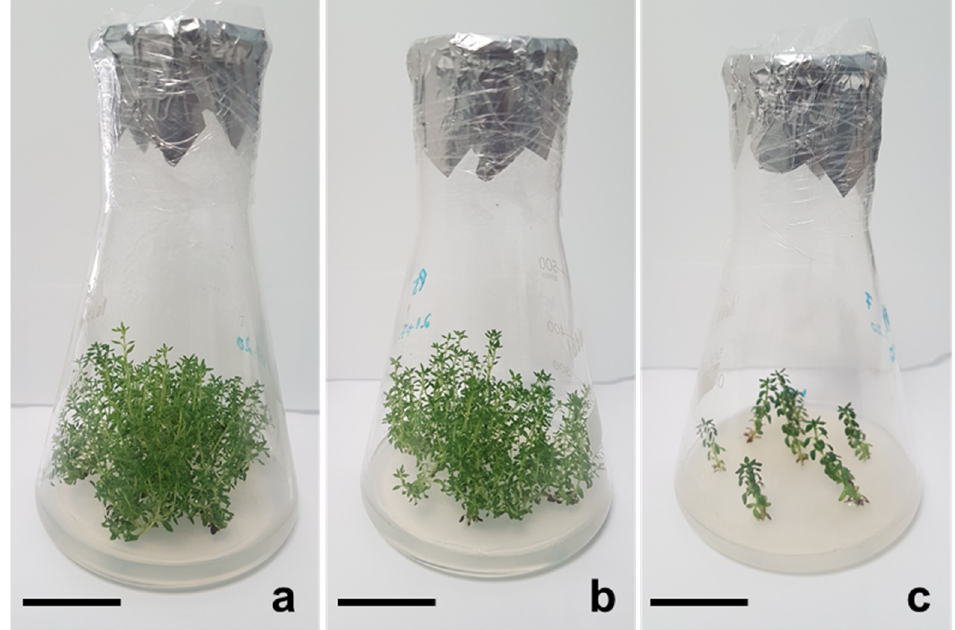
Figure 1. Thymus lotocephalus shoots after an eight-week culture. Control ( a ), CMC100 ( b ) and Chit1000 ( c ) media. The scale bars represent approximately 4 cm. CMC: carboxymethyl cellulose sodium salt; Chit: chitosan; 100: 100 mg L − 1 ; 1000: 1000 mg L − 1